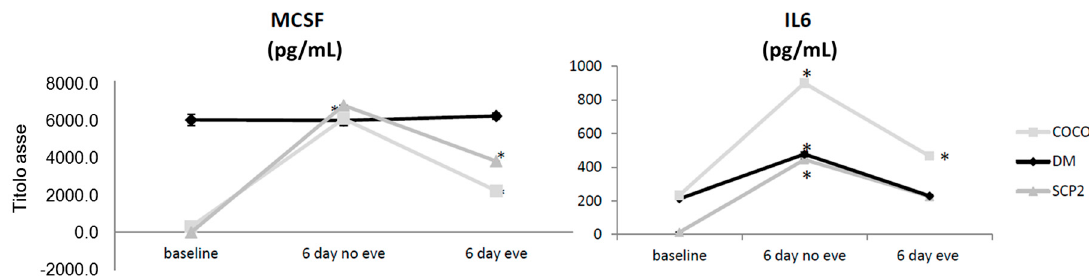
Figure 2. Cytokine secretion over time and after Eve treatment: soluble mediators over time and in presence/absence of Eve. T test was performed; Significance to t test: * p < 0.05.